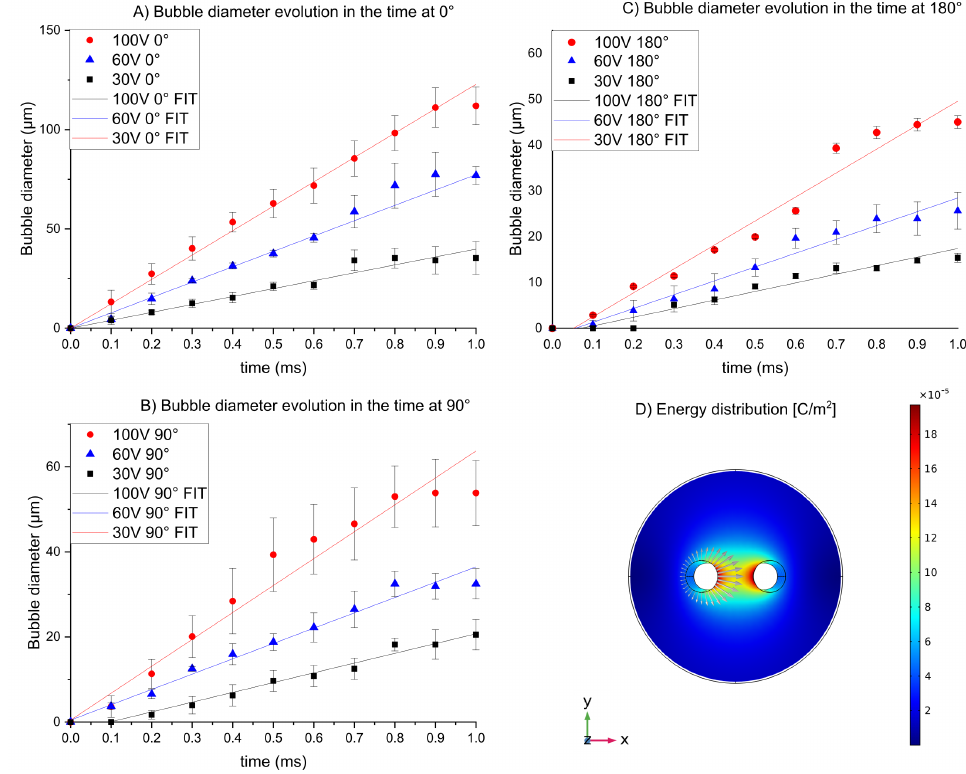
Figure 7. Average Bubble diameter as function of time and simulations of energy distribution and current density vectors. ( A ) Bubble measurements at 0°. ( B ) Bubble measurements at 90°. ( C ) Bubble measurements at 180°. ( D ) Energy distribution and current density vectors. (Data set in Supplementary